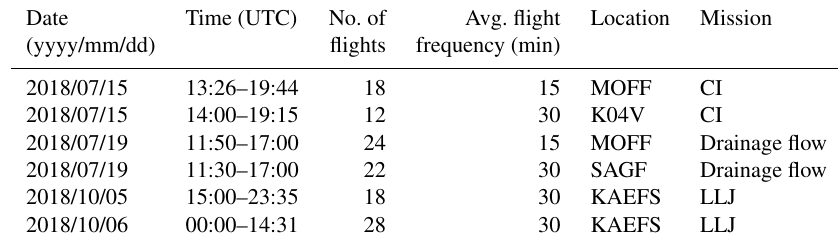
Table 1. Summary of CopterSonde flights from Flux Capacitor and LAPSE-RATE.